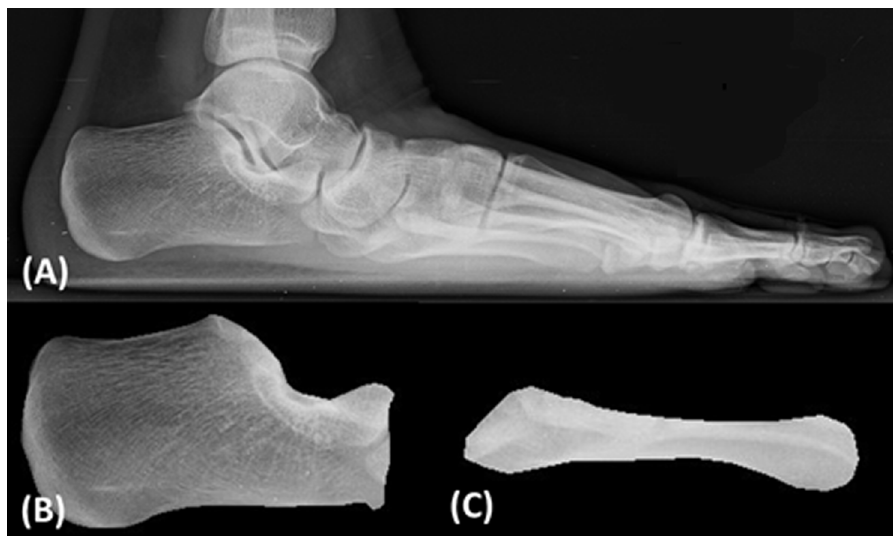
Fig 2. Lateral radiographic image of a participant. (A) The original radiographic image. The reference images of the calcaneus (B) and the fifth metatarsal bone (C) isolated from (A).